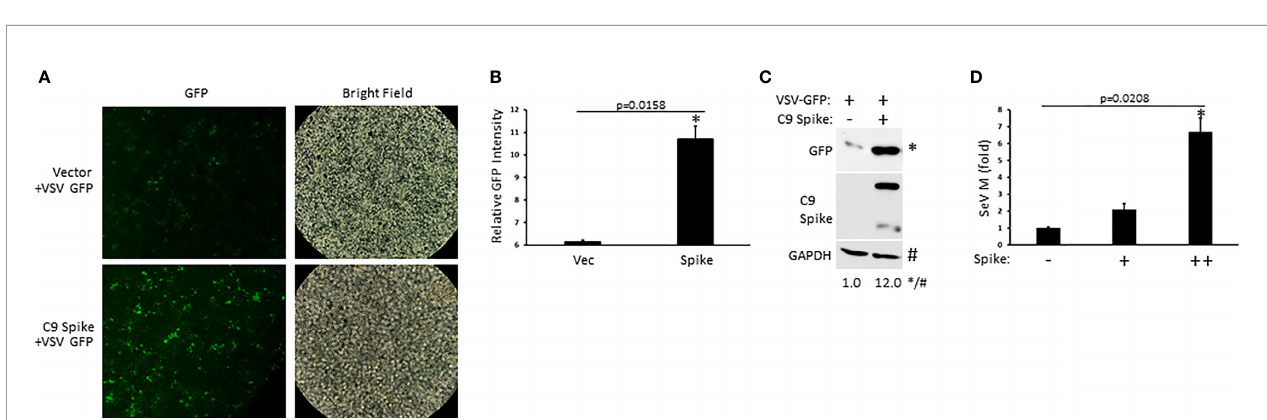
FIGURE 2 | SARS-CoV-2 Spike promotes higher RNA viral loads. (A) Fluorescent imaging of HEK 293T cells transfected with control vector or C9 Spike (2 µg) (left panels) and subsequently infected with vesicular stomatitis virus (VSV)-GFP (MOI = 0.01) for 16 h. Right panels, bright fi eld image. (B) Relative quanti fi cation of GFP intensity from A using ImageJ software. (C) Immunoblot analysis of VSV-GFP in HEK 293T cells transfected with control vector or C9 Spike (2 µg) and infected with VSV-GFP (MOI = 0.01) for 16 h. GAPDH serves as a loading control. (D) Expression levels of Sendai virus (SeV) M gene determined via Q-PCR in HEK 293T cells transfected with C9 Spike (0.25 and 1 µg) and subsequently infected with SeV (MOI = 0.01) for 16 h. *Indicates p < 0.05 as determined by the student ’ s t-test. Results are representative of two independent experiments. The relative band intensity (*/#) of GFP in (C) was measured using ImageJ